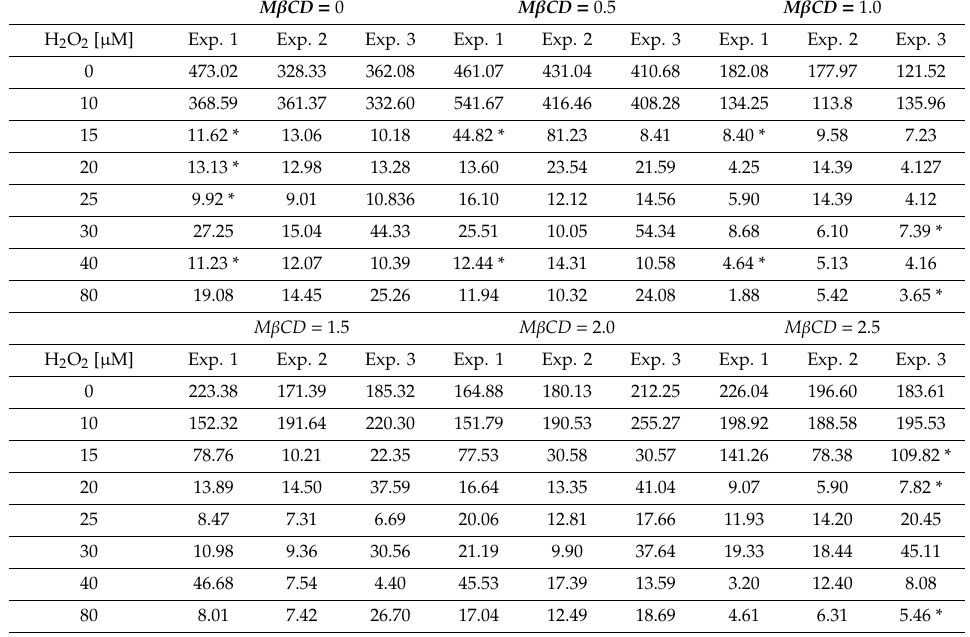
Table 2. Triplet cellular viability experiments for di ff erent H 2 O 2 doses and M